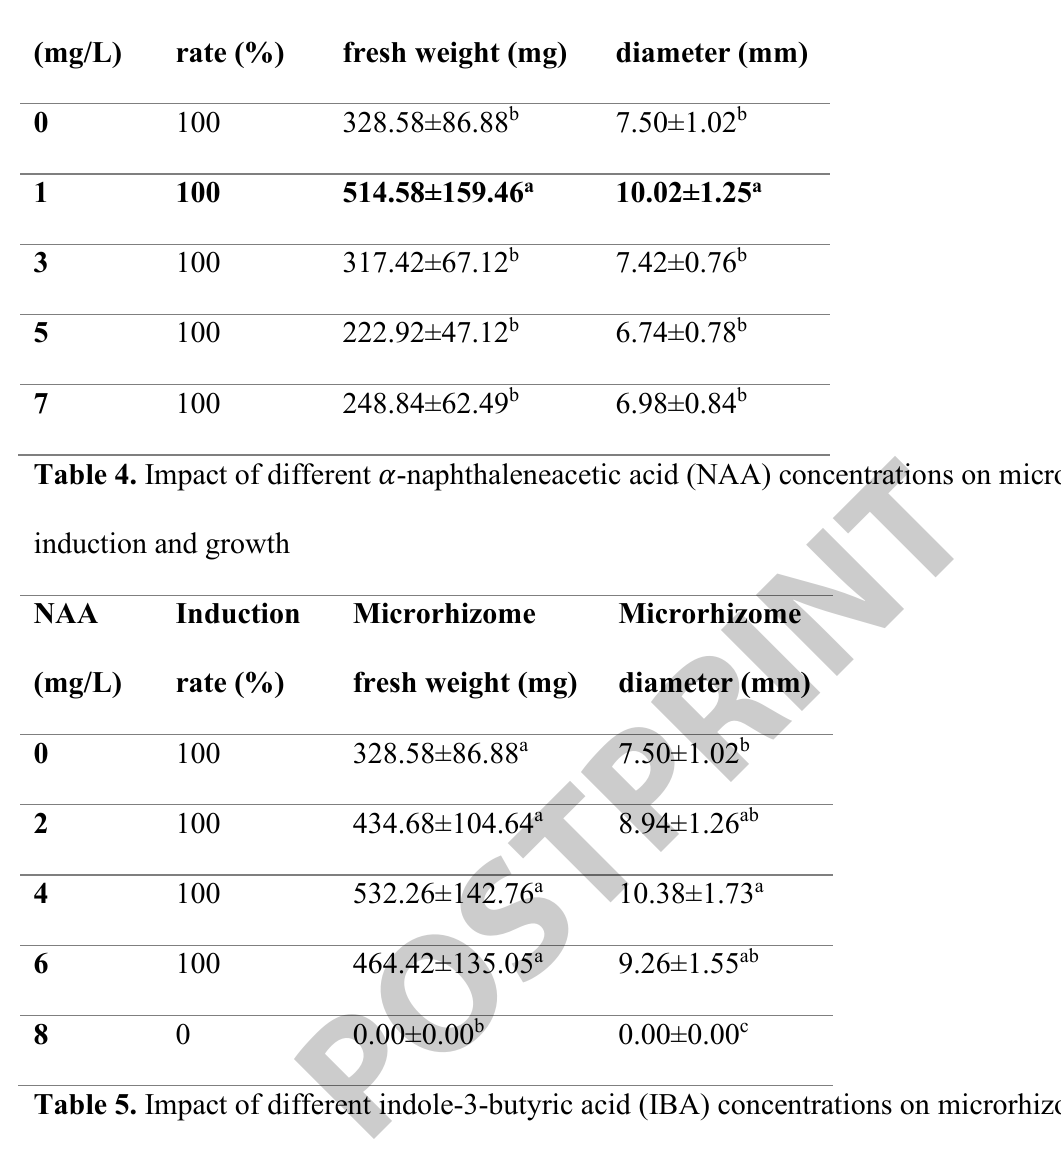
Table 3. Impact of different kinetin (KIN) concentrations on microrhizome induction and growth KIN